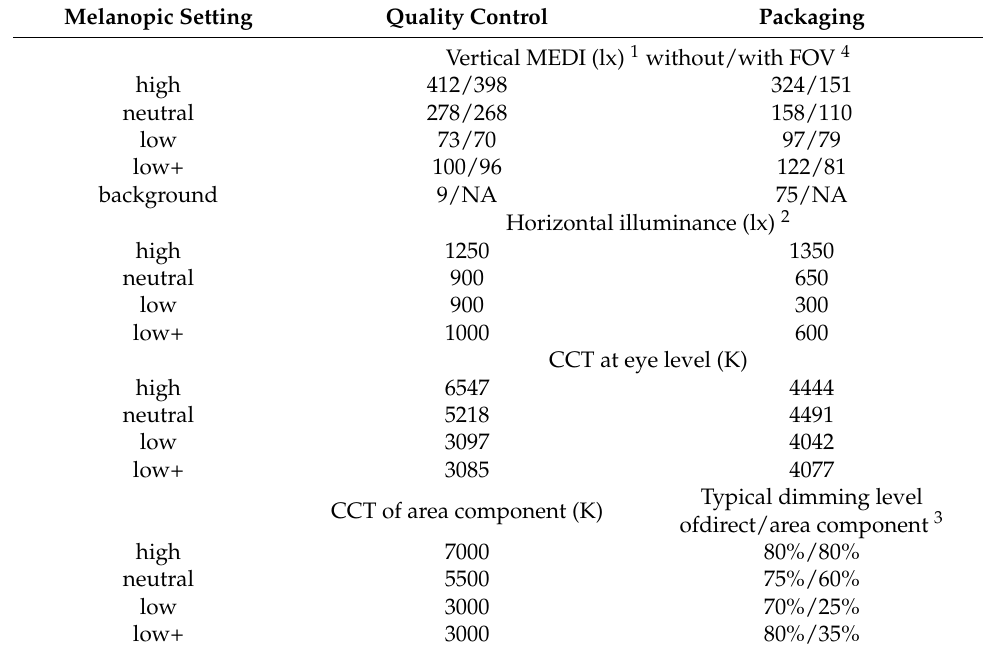
Table 2. Lighting measurements and automation setting with the new lighting